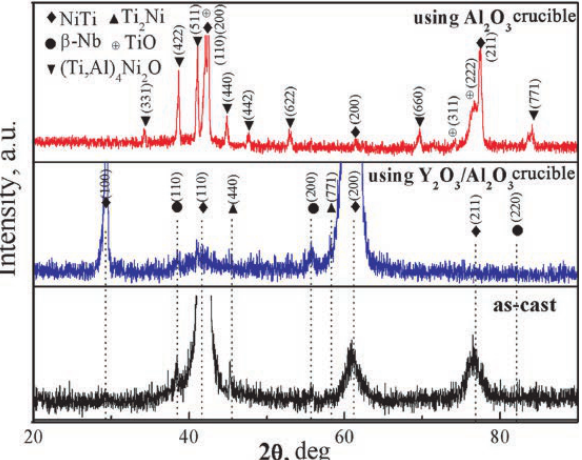
Fig. 1: XRD diffraction patterns of the